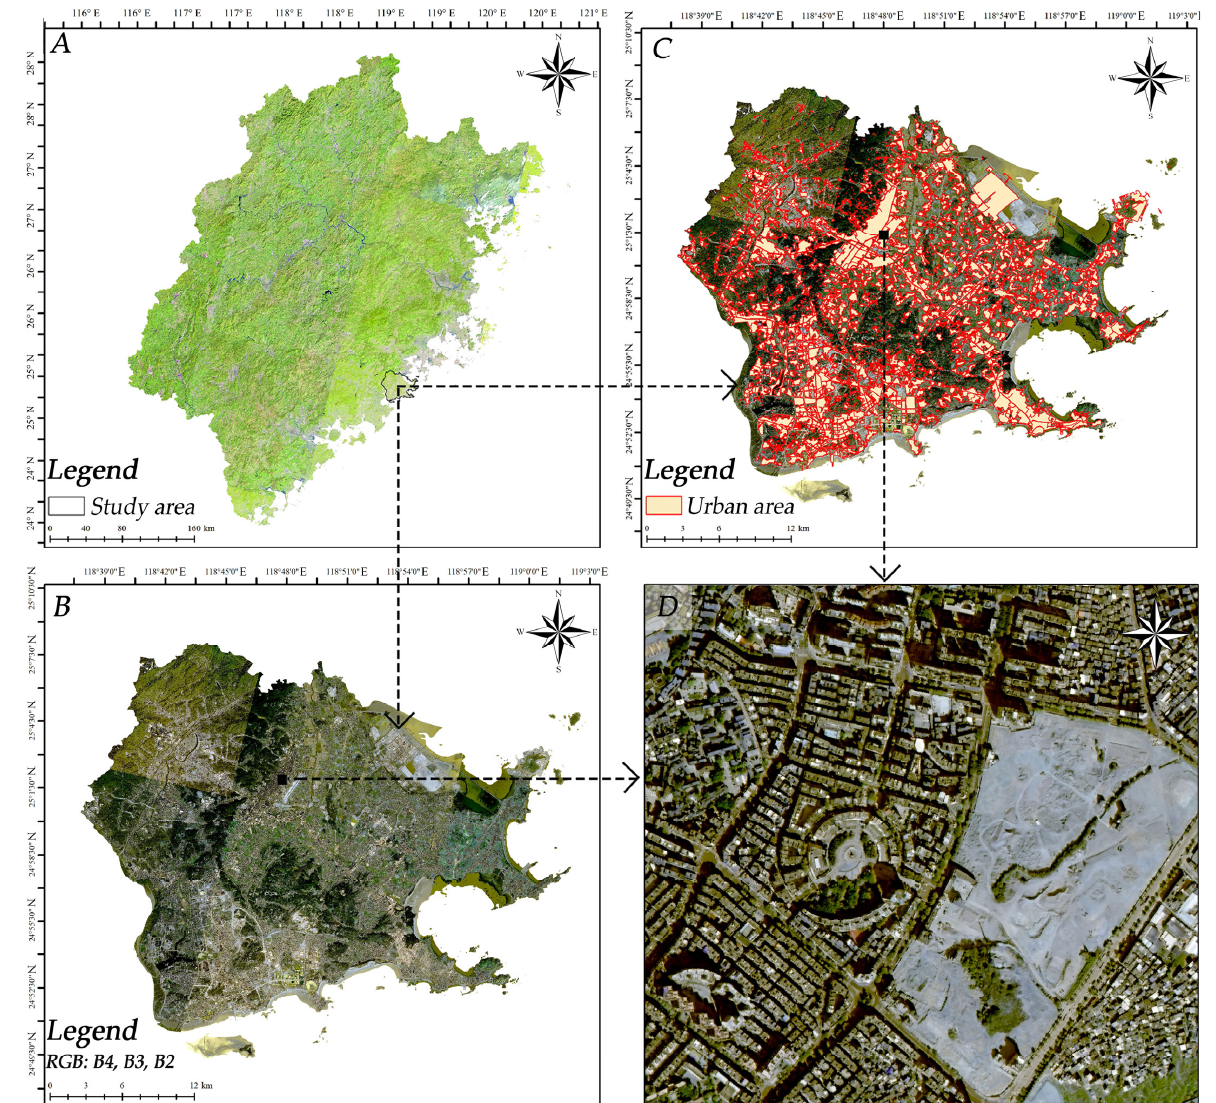
Figure 1. Study area: ( A ) the location of study area in Fujian province; ( B ) the GF ‐ 2 images of study area; ( C ) the distribution of urban areas of study area; ( D ) the images after superpixel ‐ enhancement.